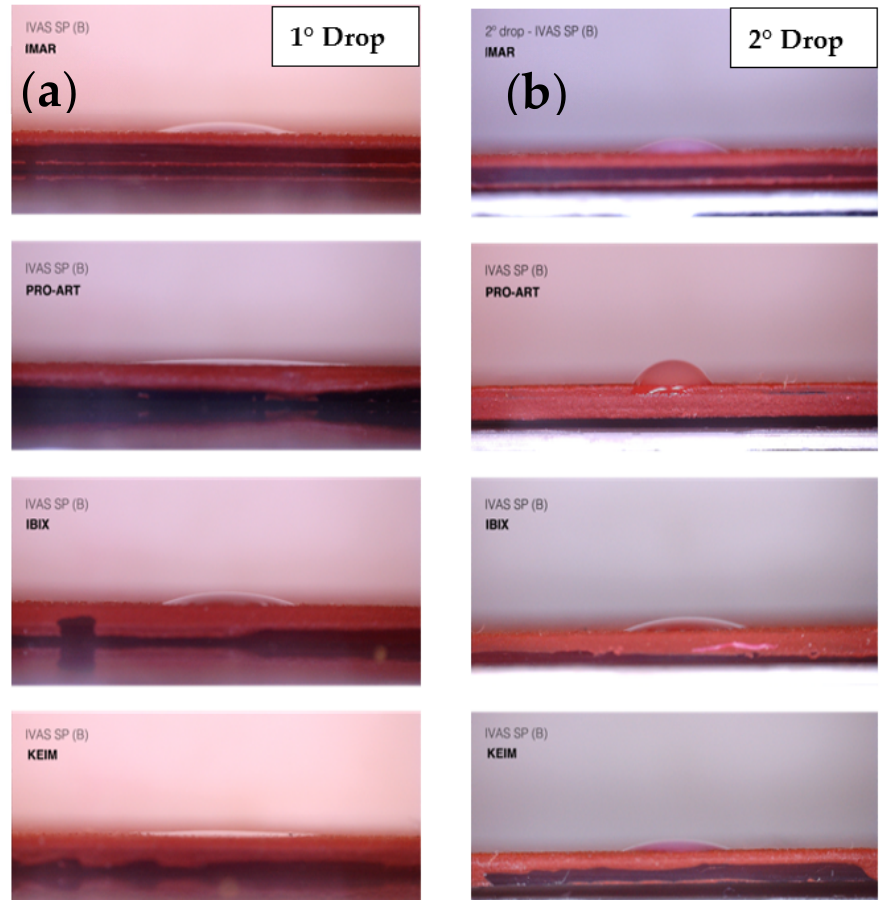
Figure 4. Coatings wetting test on Ivas SP: ( a ) first coating drop and ( b ) second coating drop. The lower wettability is due to the formation of a hydrophobic layer on the surface. This could represent a drawback, since if a hydrophobic surface is created a second layer of coating (which is water-based) is hardly applicable in the short-term. Colorimetric measures were performed after application of the coatings and again after four months. Figure 5 shows the differences between the two sets of measurements. Good performance was achieved by IMAR on MTN94 and on Ivas SA, but for the other paints, greater colorimetric differences were detected. The best performances were shown by PRO-ART on MTN94, Ivas SP and MTN WB, while poor performance was demonstrated on LOOP. IBIX does not show a good performance on any paint, while KEIM produces the greatest colorimetric difference.